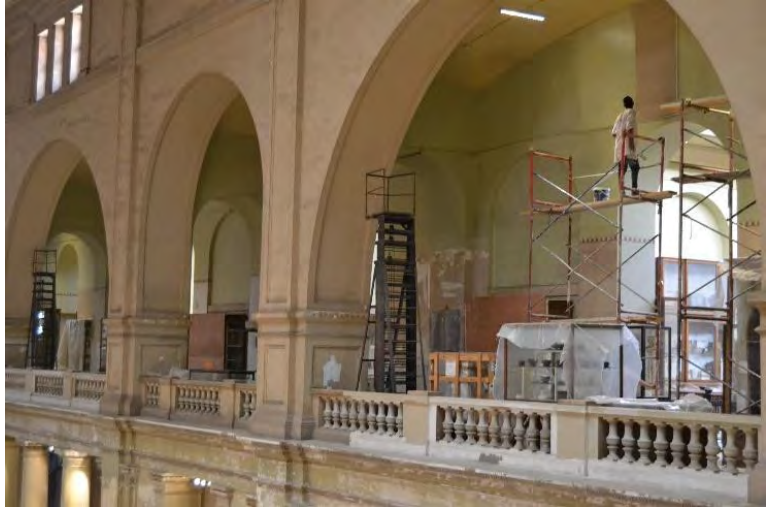
Figure 6. Photo for the Revival process in the first floor (Taken by the author on